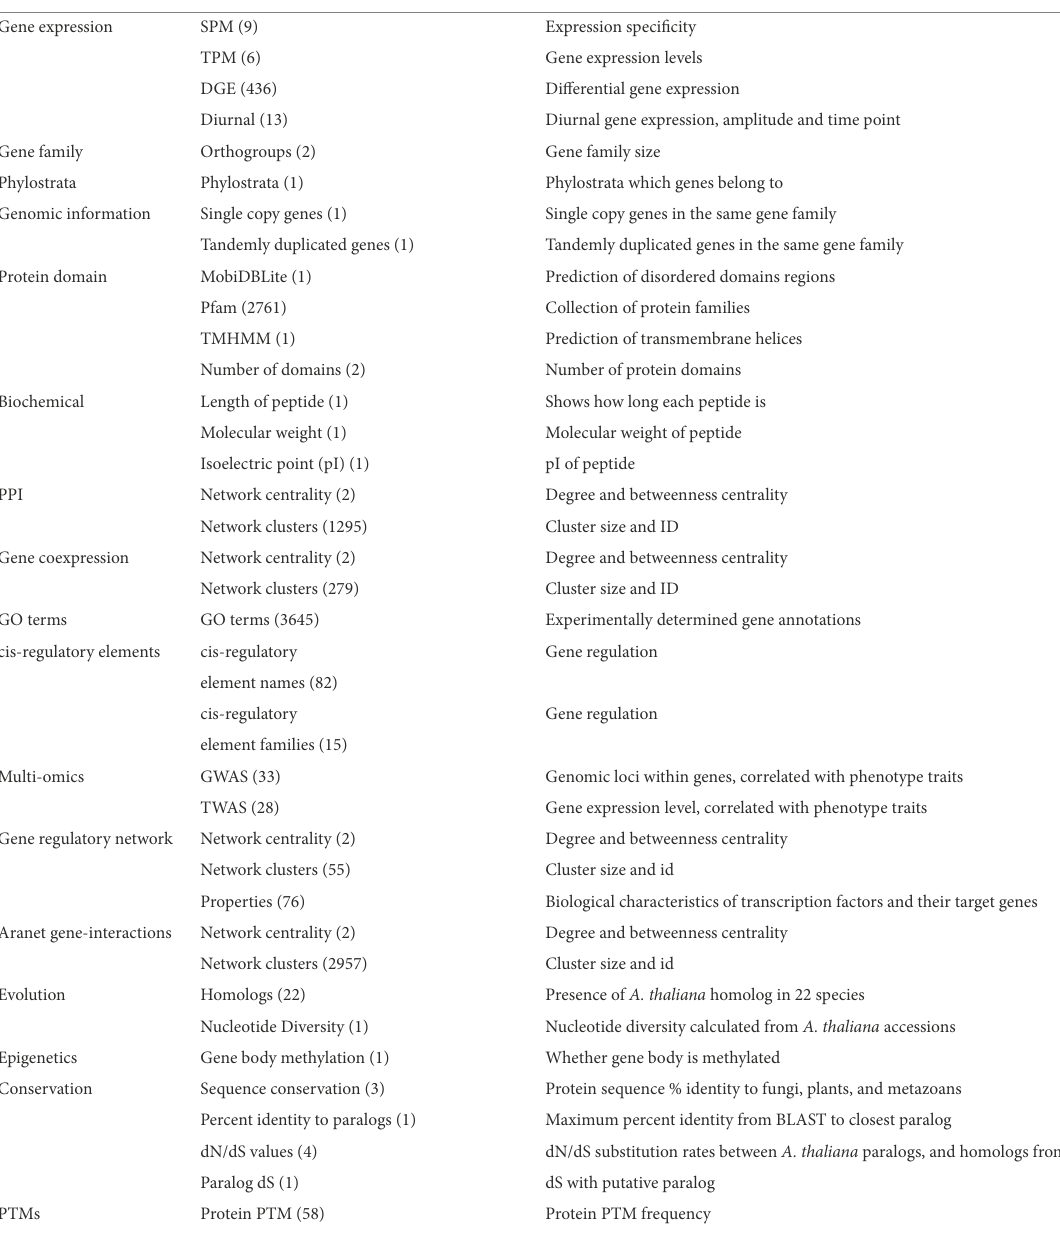
TABLE 2 Summary of features